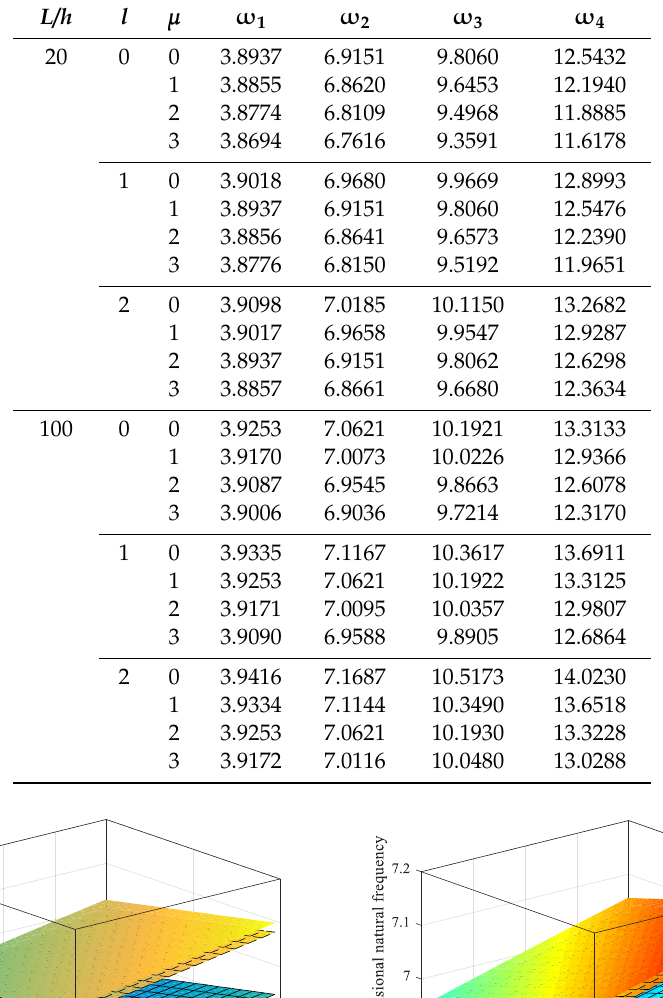
Table 5. Effect of the L/h and small-scale parameters on the natural frequencies for a clamped-simply supported triclinic nanobeam.